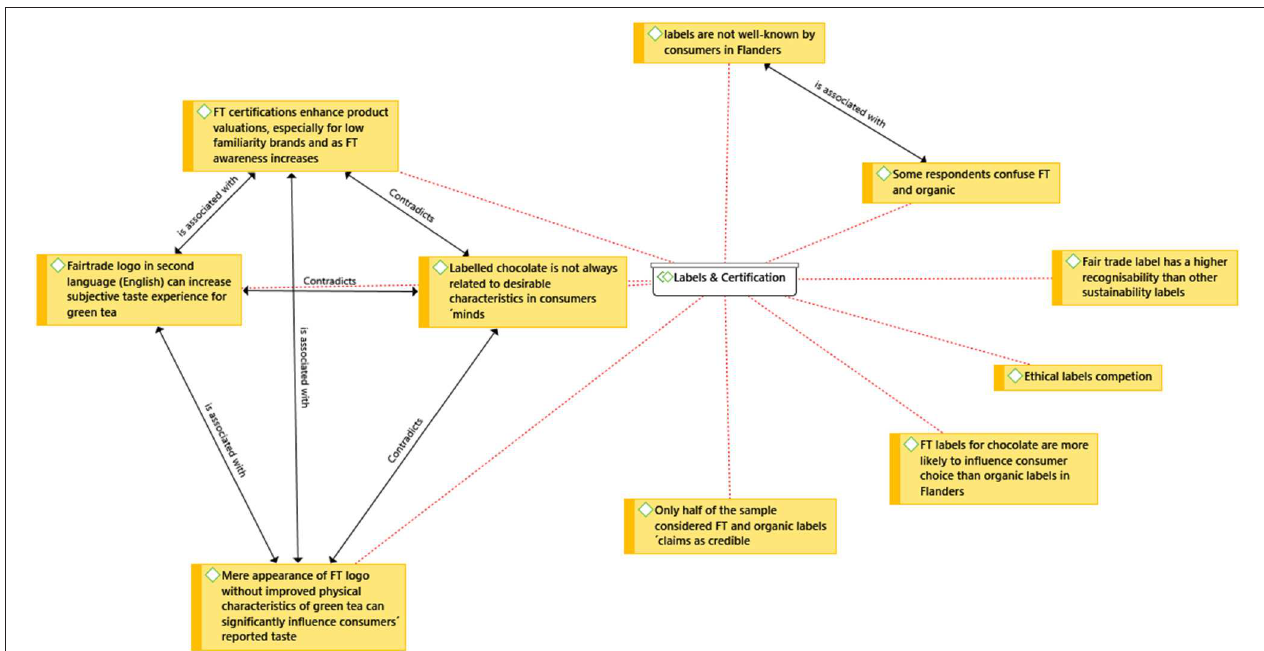
FIGURE 5 | Network analysis: Labels and certification.